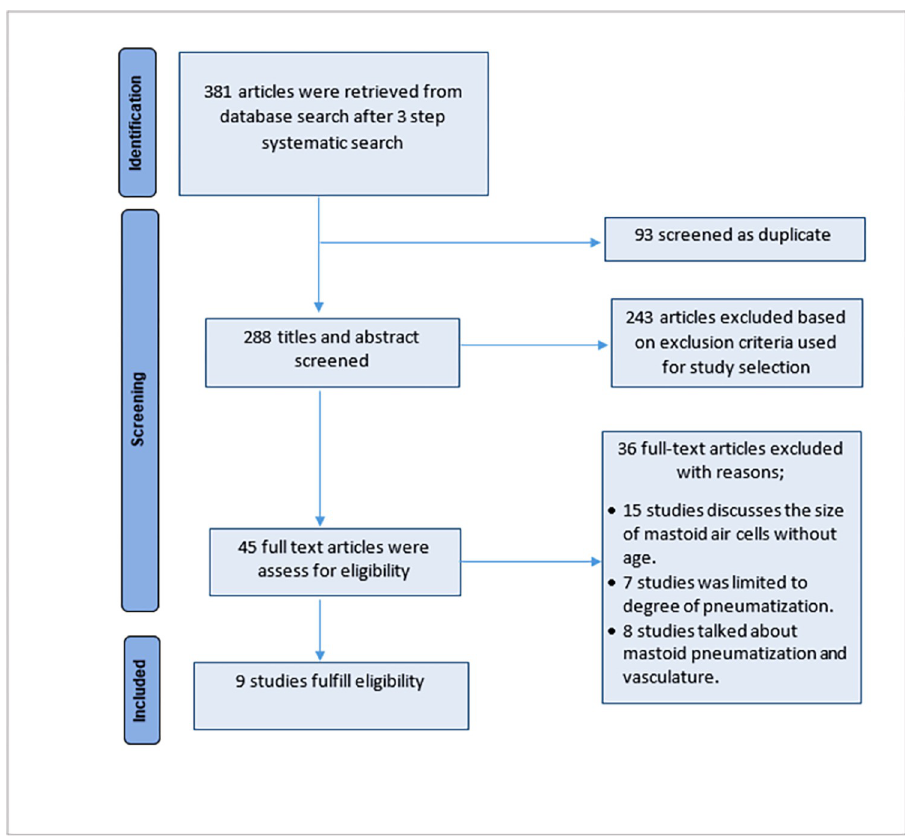
Fig 1. Flow diagram for study